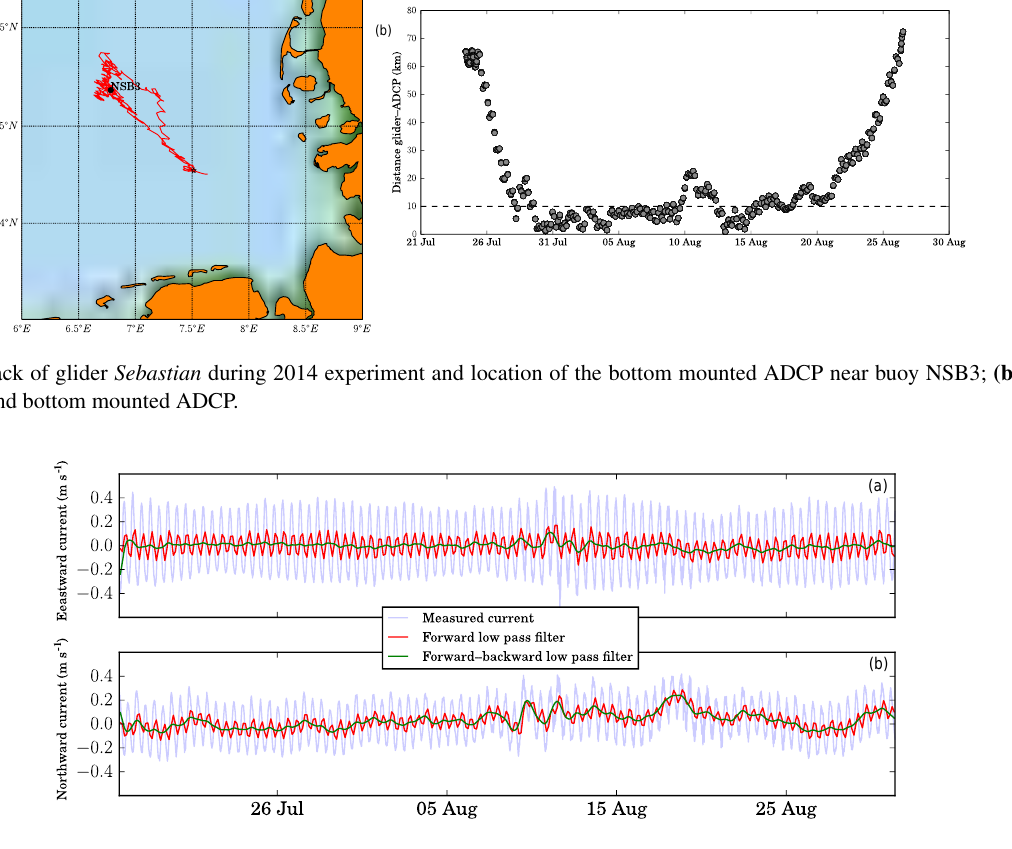
Figure 3. Eastward and northward currents are shown in the top and bottom panel, respectively. The synthetic 3h averaged currents are shown in transparent blue, and the forward and forward–backward filtered residual currents are shown in red and green,